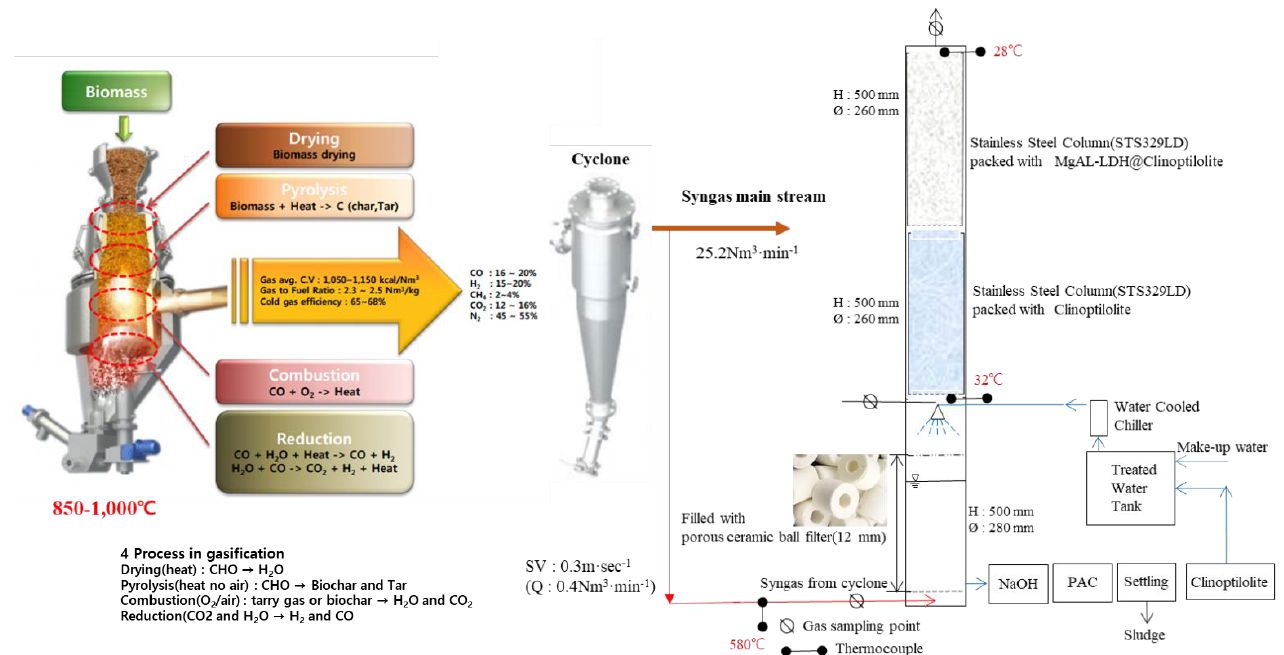
Figure 8. Schematic diagram of bench scale syngas refining reactor. 1st column: water scrubber with water spray volume 5 L · min − 1 , diameter 280 mm, height 500 mm, filled with ceramic ring filter (height 300 mm), spray water temperature below 20 ℃ , 2nd column: reactor filled with prepared clinoptilolite, diameter 260 mm and height 500 m, 3rd column: reactor filled with prepared Mg/Al − LDH@clinoptilolite, diameter 260 mm and height 500 m (Gasifier structure and operation parameters source: Samyang Econergy Inc. in